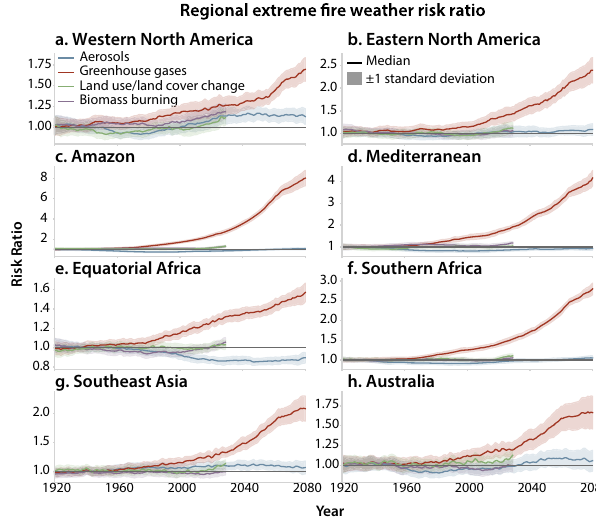
Fig. 2 Regional extreme fi re-weather risk ratio. Regional time series of the 30-year moving risk ratio (RR) of extreme fi re weather for different anthropogenic forcings. The 30-year RR is the regionally-averaged probability of exceeding the 95th percentile of the 30-year moving window daily fi re-weather index (FWI) in the all-forcing (ALL) ensemble divided by the regionally-averaged probability of exceeding that same threshold in the all-but-one aerosol (blue), greenhouse gas (red), biomass burning (purple), and land-use/land-cover (green) X ensembles. The shaded envelope represents one standard deviation of the ensemble spread. Regional de fi nitions are shown in Fig. 1h and Supplementary Table 2 and are a Western North America, b Eastern North America, c Amazon, d the Mediterranean, e Equatorial Africa, f Southern Africa, g Southeast Asia, and h Australia. All-but-one aerosol and greenhouse gas X simulations are run to 2080, while all-but-one biomass burning and land-use/land-cover X simulations are only run to 2029 (see “ Methods ”